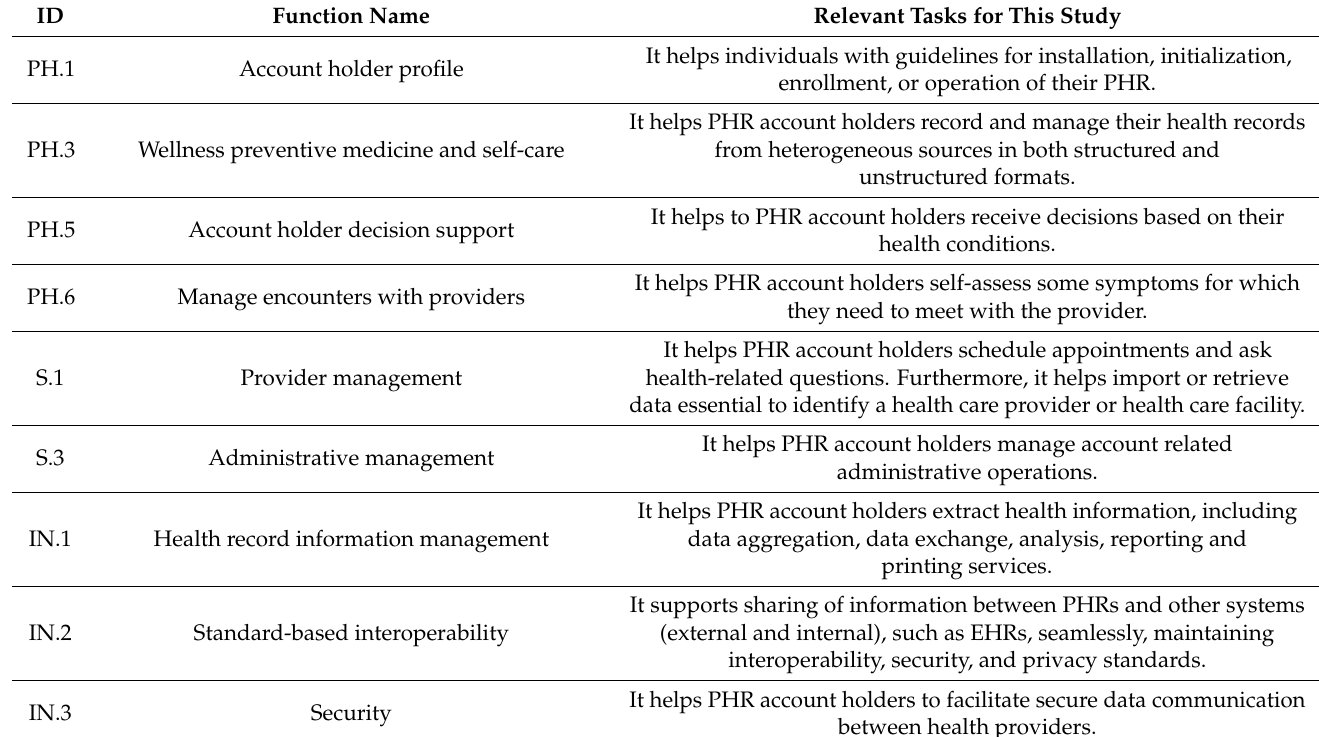
Table 2. Adopted functions defined in PHR-S FM